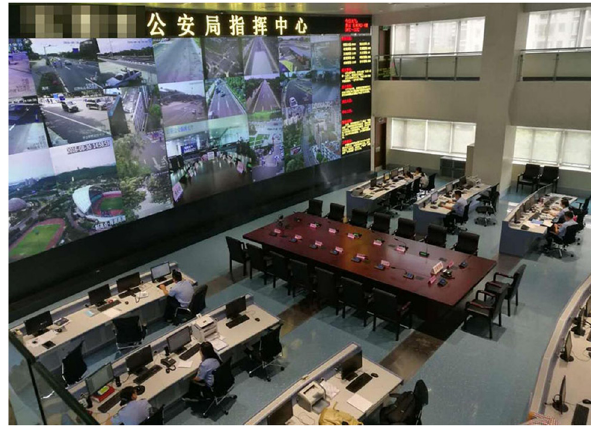
Figure 1: High - de fi nition monitoring in the command center of a public security